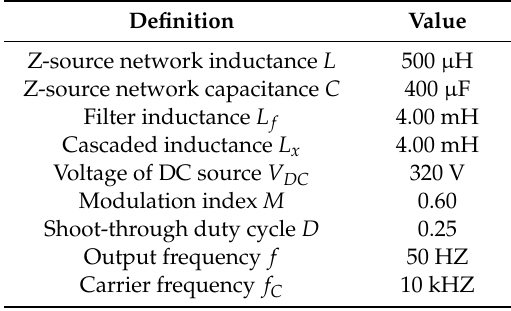
Table 6. Parameters of LVC-qZSI before optimization.